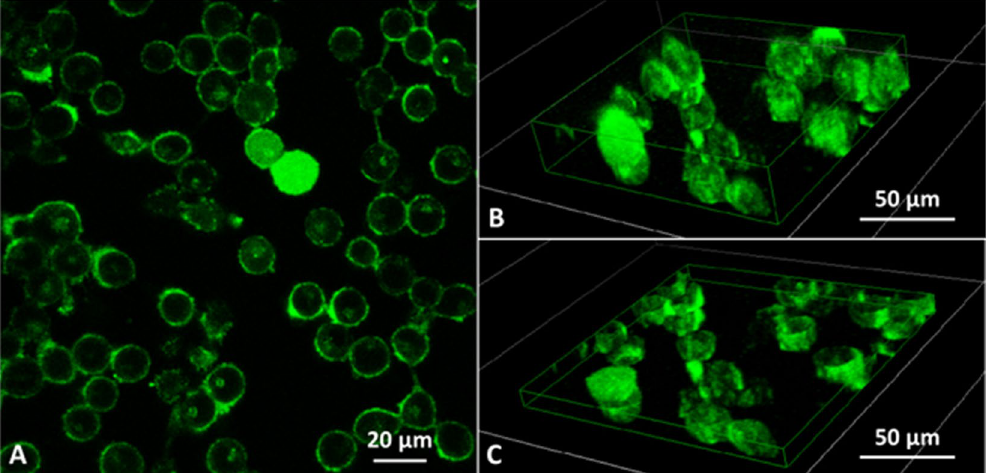
Figure 3. ( A ) Representative image acquired on HaCaT cells treated for 30 ′ with 1 MHz US at I spta = 7 mW/cm 2 with a confocal fluorescence microscopy; ( B ) and ( C ) 3D reconstruction of cells that internalised the fluorescent dye calcein: the section ( C ) evidences a two level uptake, diffused in the cytosol and localised on the biological membrane.